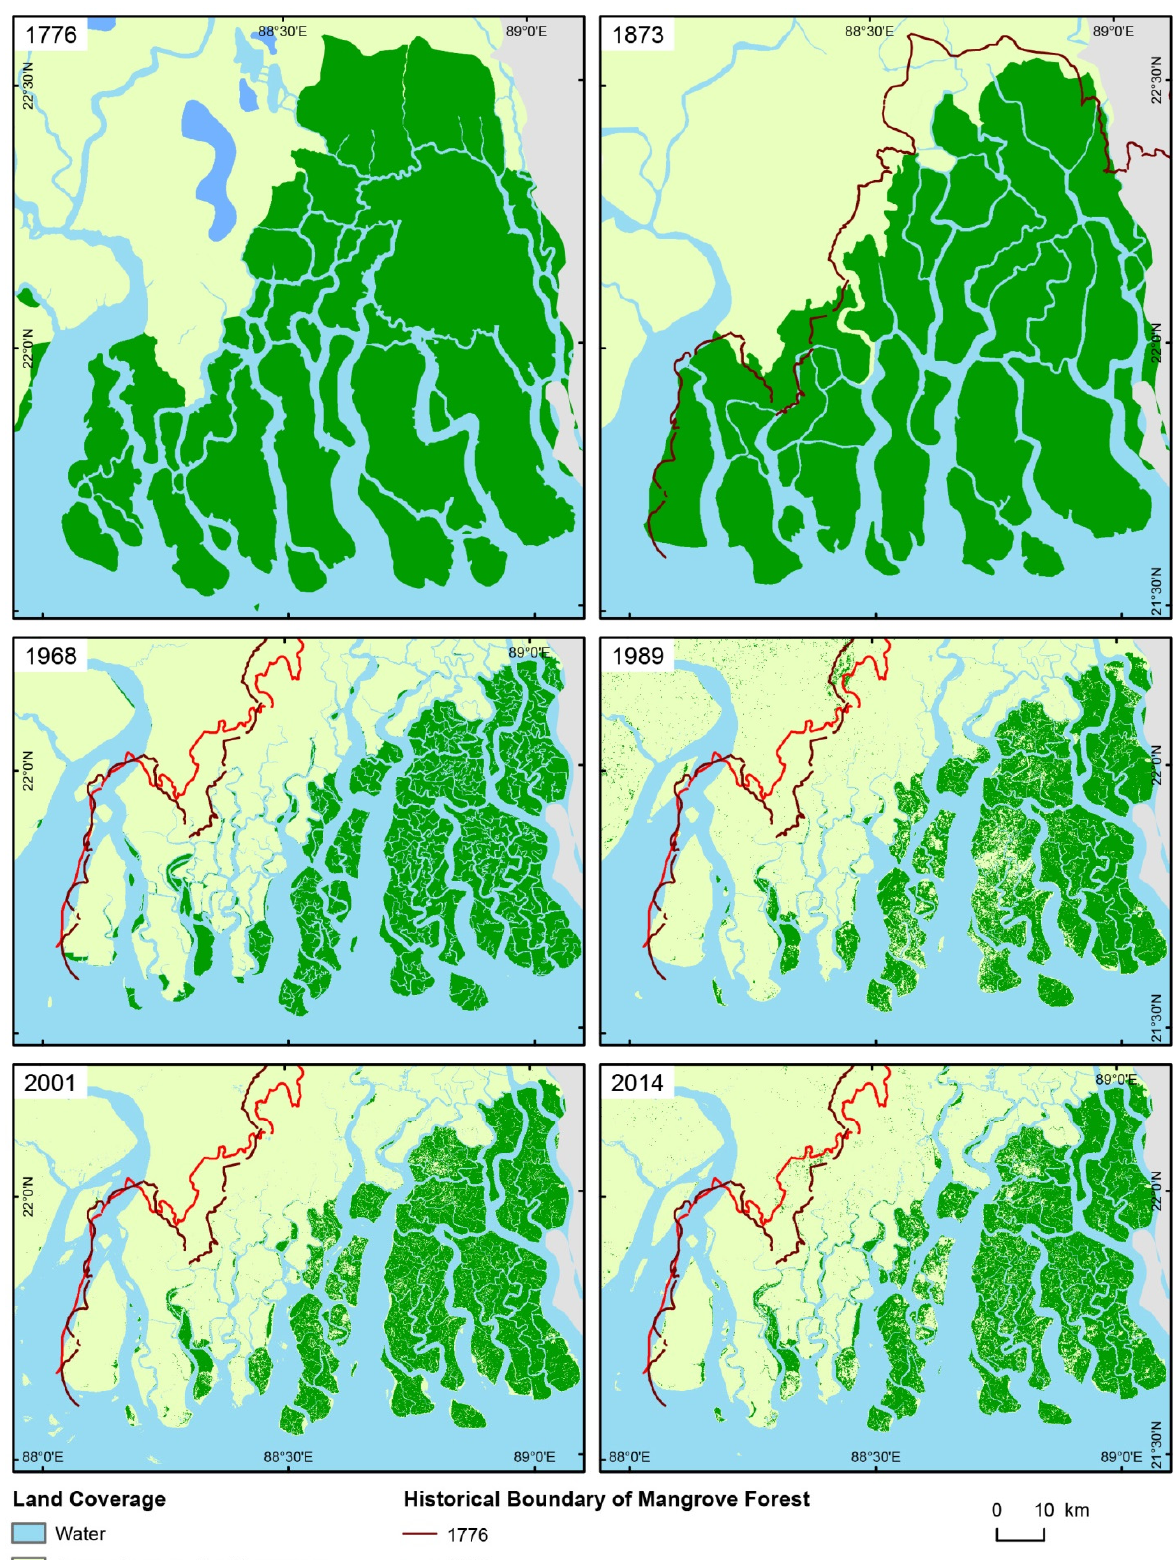
Figure 2. Mangrove extent and cover at various dates between the 18th and 21st century. For data used see Table 1, for change statistics see Table